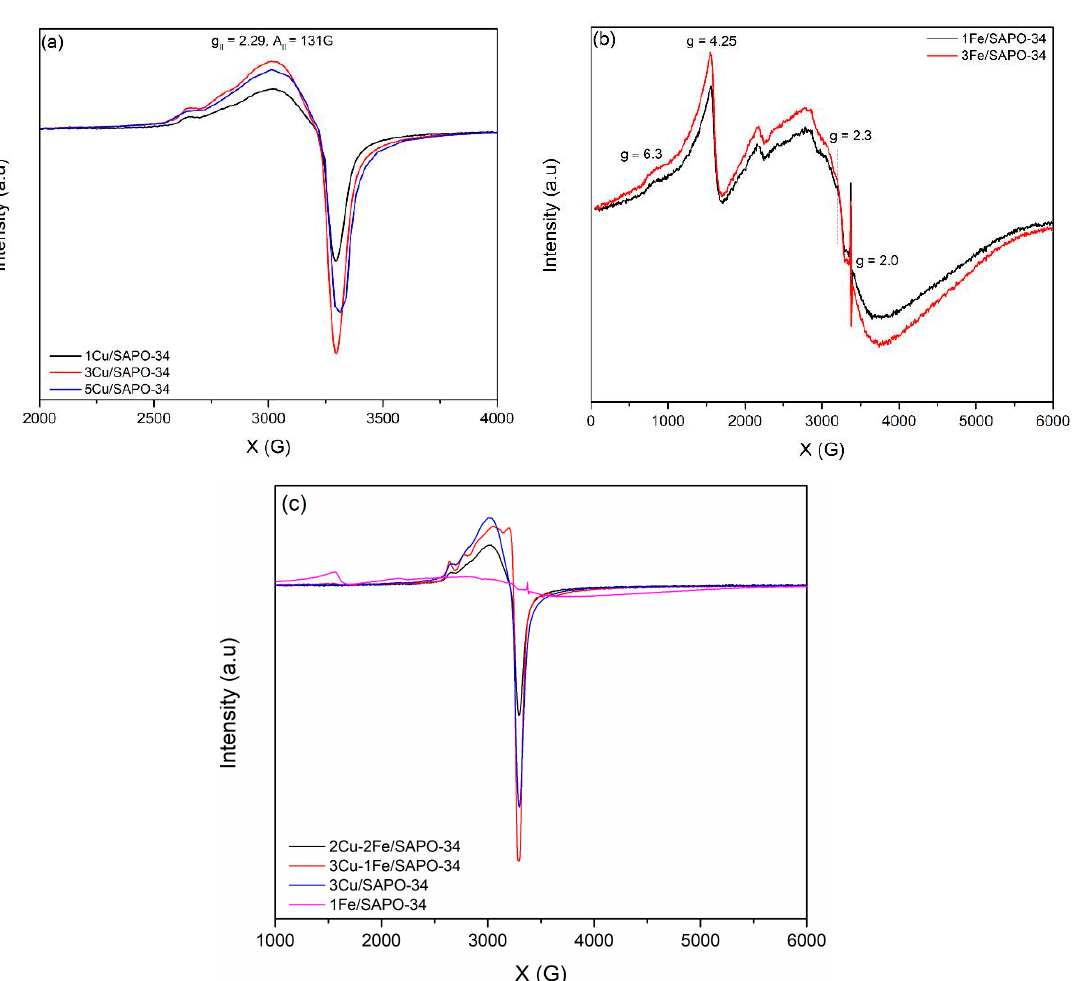
Figure 6 . UV–Vis DRS spectra of the Cu/SAPO-34, Fe/SAPO-34 and Cu-Fe/SAPO-34 samples.